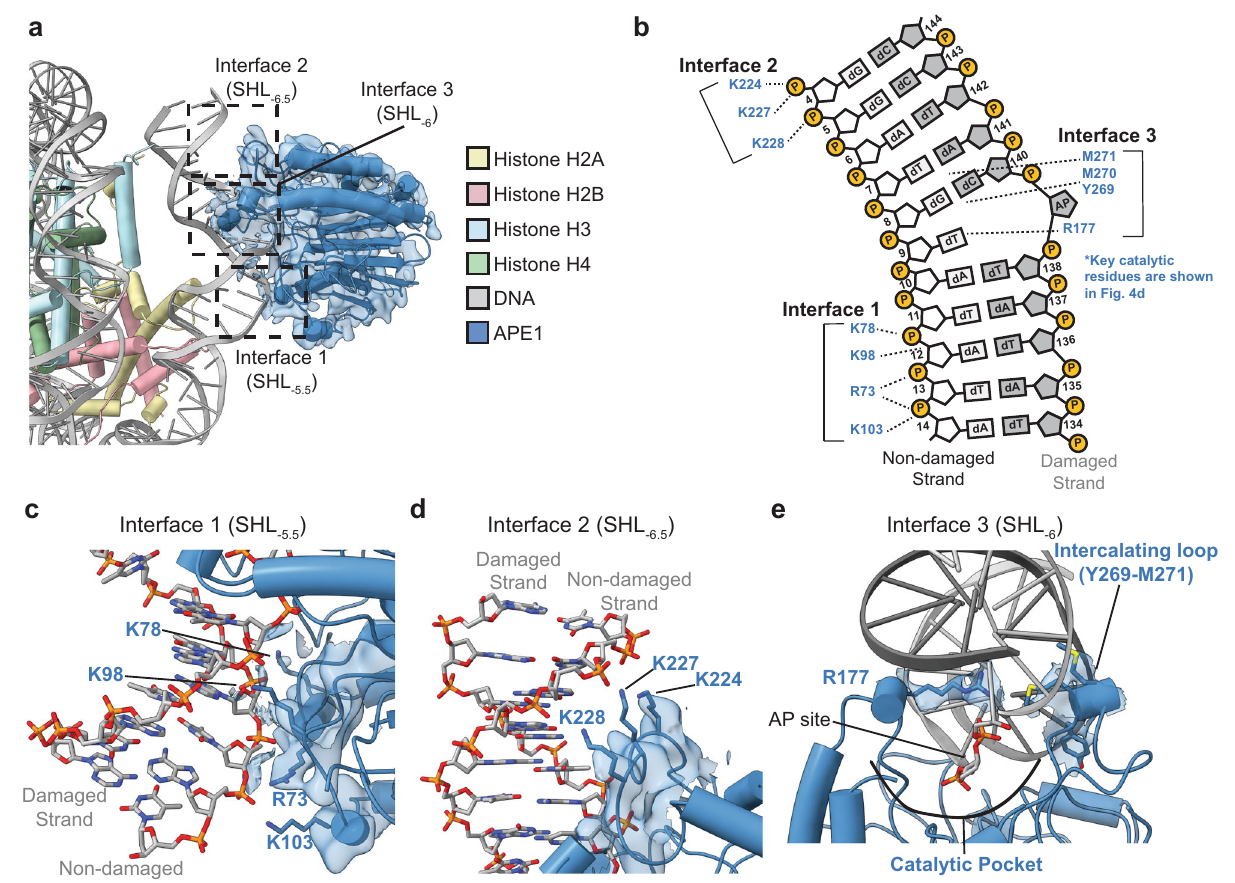
Fig. 3 | APE1 interacts with AP-NCP -6 using three molecular interfaces. a A focused view of the APE1-AP-NCP -6 complex. Black dotted squares denote the three distinct molecular interfaces. The segmented APE1 cryo-EM map is shown as a transparent blue surface. b A diagram representing the contacts between APE1 and the nucleosomal DNA identi fi ed using PLIP 66 . Several APE1 catalytic residues are not shown for clarity (see Fig. 4e). c Focused view of cleave APE1-AP-NCP -6.5 and APE1-AP-NCP 0 , we utilized the product